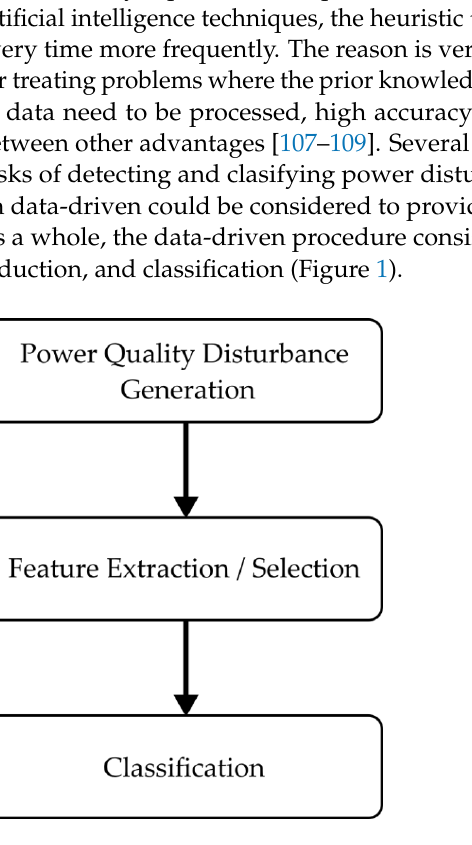
Figure 1. The typical process for Power Quality failure detection methodology [110].